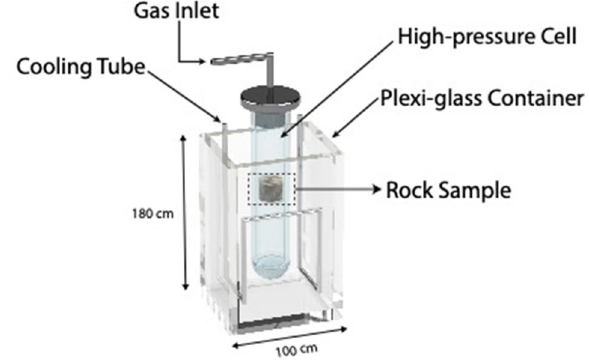
Figure 8. Cooling liquid bath used to reduce the rock’s temperature below ambient temperature (20 °C, 293.15 °K). The cooling liquid (water) was placed in the plexi-glass container and cooled gradually by the cooling metal tube.